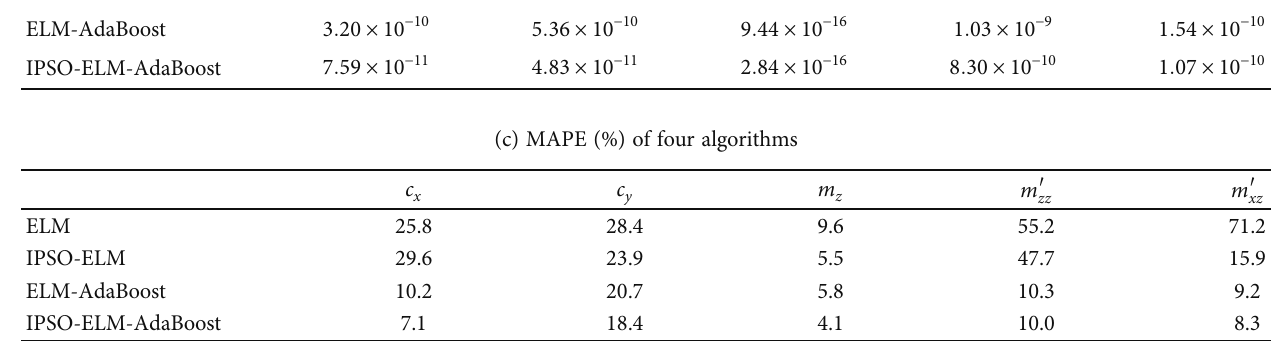
(c) Mean Absolute Percentage Error (MAPE) . MAPE is a relative error measure that uses absolute values to avoid positive and negative errors canceling out.